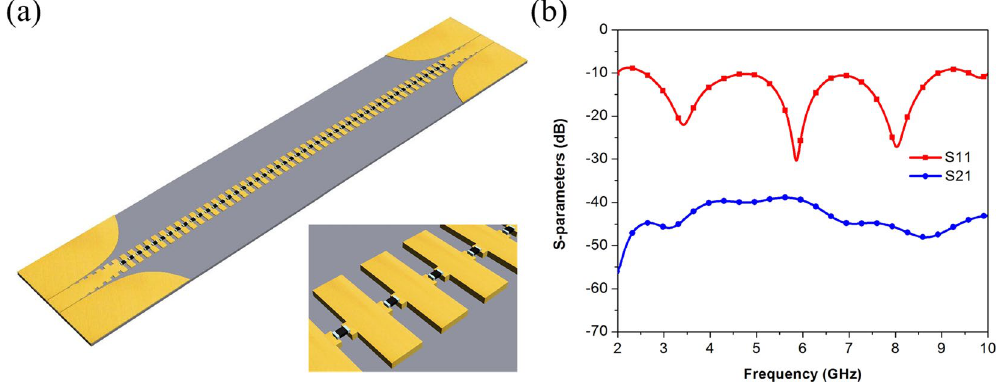
Figure 2. ( a ) The configuration of loaded TL with resistors. ( b ) The simulated S-parameters of loaded TL with resistors.